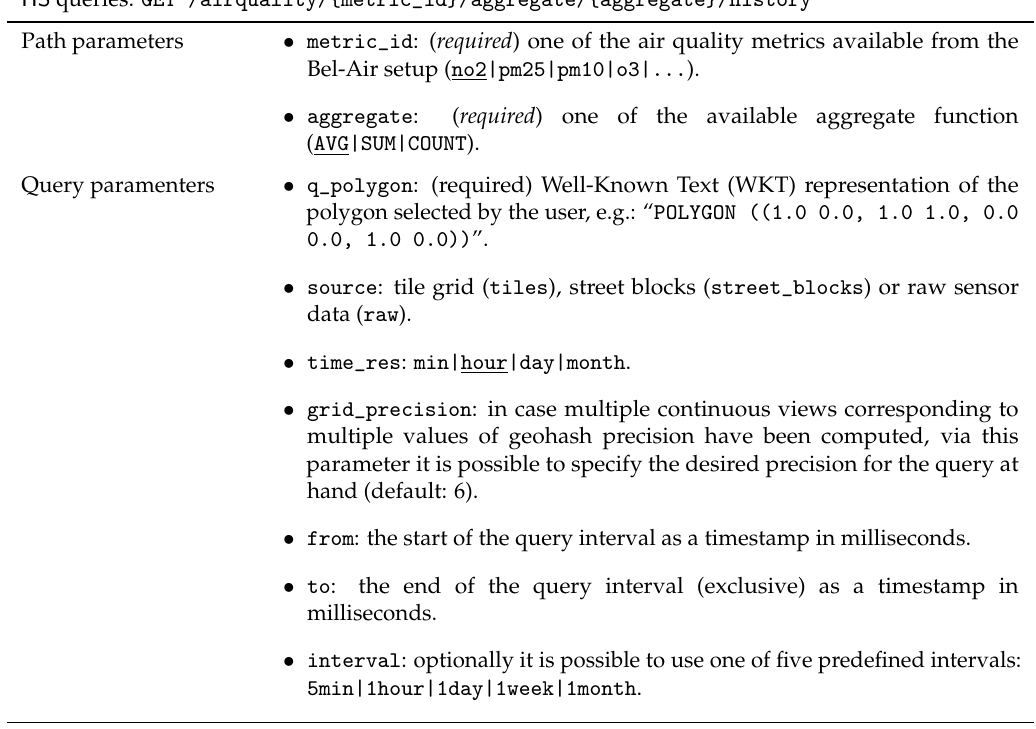
Table 1. API specification for the serving layer (default values are shown in underlined